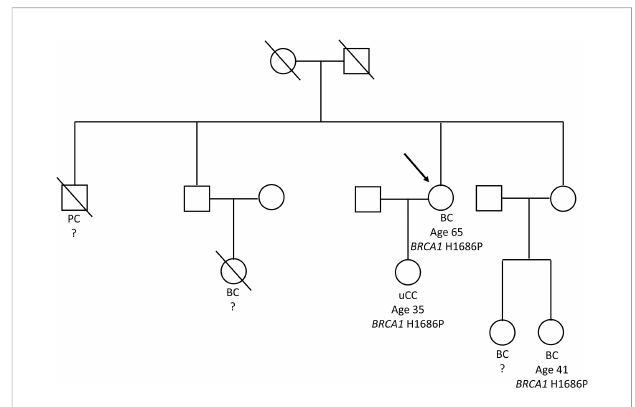
FIGURE 1 Tree of the Ukranian family bearing the BRCA1 p.His1686Pro variant. The fi gure shows the family tree with details about BRCA1 genotype and cancers occurrence. The proband was depicted with an arrow. BC, breast cancer; PC, pancreatic cancer; uCC, adenocarcinoma of the uterine cervix.